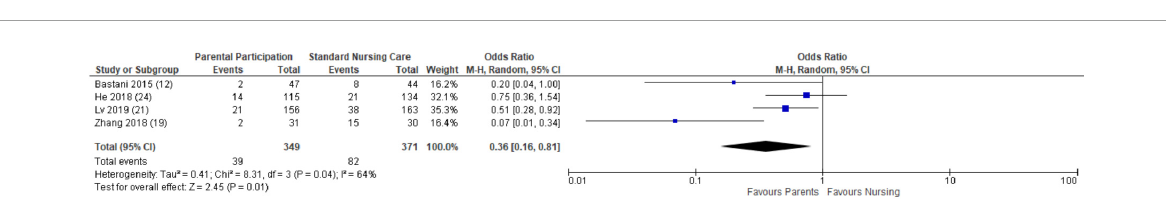
FIGURE6 Forest plot and meta-analysis of the association between parental participation and hospital